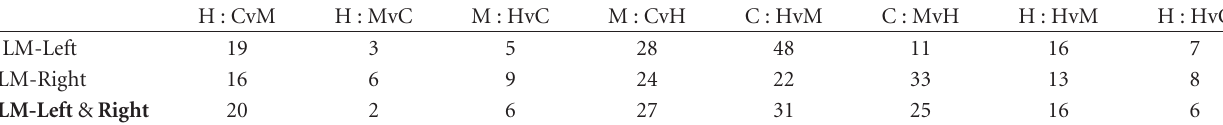
Table 1: Output of classifier based on the Wilcoxon-Mann-Whitney test statistic. For example, the first numerical column, “H : CvM,” gives the number of HR classified as CTRL versus MDD and the second numerical column, “H : MvC,” gives the number of HR classified as MDD versus CTRL. Thus, we find that combining left and right, the shape comparisons LM (LM-Left and Right) yields 20 HR classified as CTRL versus 2 HR classified as MDD—strong statistical evidence that HR is more like CTRL than MDD in hippocampus shape space. (This analysis is based on 22 HR subjects, 33 MDD subjects, and 59 CTRL subjects. Thus, e.g., the two HR numbers, H : CvM and H : MvC, should sum to 22. Discrepancies are due to situations in which the classifier makes “no decision” as described in [17]; (see also [15, page 183]). H : CvM H : MvC M : HvC M : CvH C : HvM C : MvH H : HvM H : HvC LM-Left 28 48 11 16 7 LM-Right 16 6 9 24 22 33 13 8 LM-Left & Right 20 2 6 27 31 25 16 6